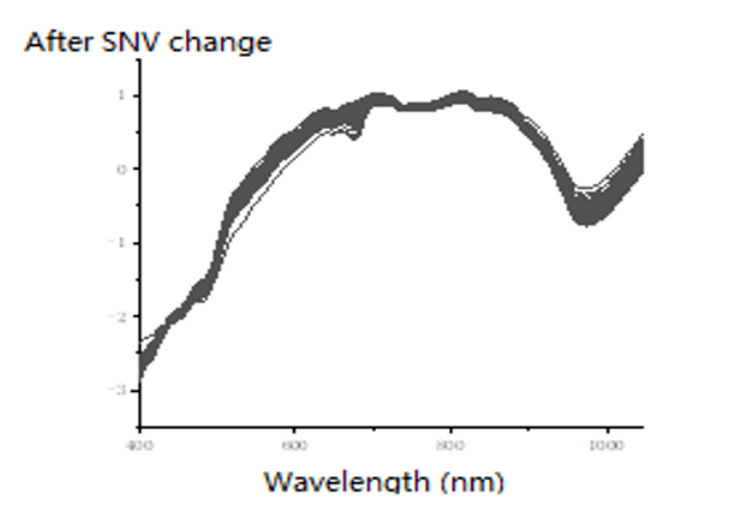
Fig. 2. Spectral image preprocessed by MSC spectrum.